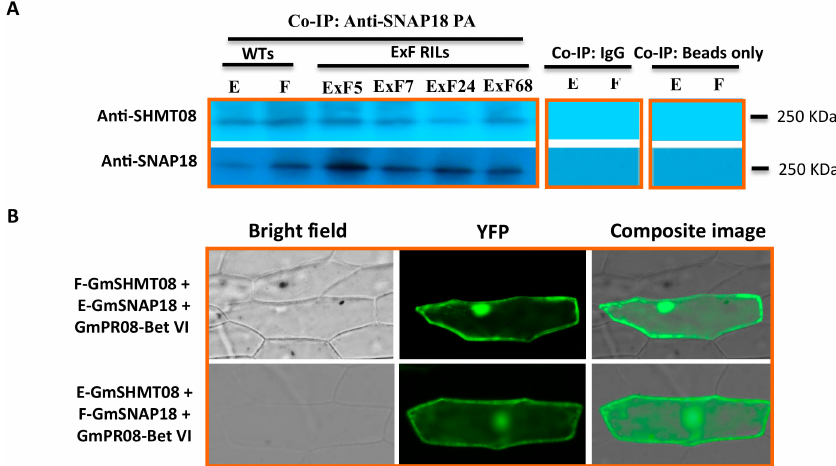
Figure 2. Interaction analyses of GmSNAP18 and GmSHMT08 proteins carrying resistant and susceptible allele combinations by Co-immunoprecipitation (Co-IP) and BiFC assay. ( A ) The total protein extracts of soybean Forrest, Essex, and four ExF RIL (Figure S1) roots were immunoprecipitated with Anti-GmSNAP18 PA. Blots from the eluted fraction were probed with both anti-SHMT08 and Anti-GmSNAP18. Upper bands on the panel (~ 250 KDa) correspond to the multi-protein complex including the tetrameric GmSHMT08 protein, lower bands on the panel (~ 250 KDa) correspond to the multi-protein complex including the GmSNAP18 protein. Native PAGE conditions (non denaturant) and western hybridization of the eluted fraction using both anti-GmSHMT08 and anti-GmSNAP18 antibodies showed the co-localization of the GmSHMT08 and GmSNAP18 binding. IgG and beads were used for Co-IP experiments as a negative control and technical control, respectively ( B ) BiFC analysis between GmSHMT08, GmSNAP18, and GmPR08-Bet VI proteins. The coding sequences of resistant Forrest (F) and susceptible Essex (E) alleles from GmSNAP18 and GmSHMT08 were cloned into pSAT4-nEYFP-C1-B and pSAT4-cEYFP-C1 to generate nEYFP-SNAP18 and cEYFP-GmSHMT08 fusions, respectively. GmPR08-Bet VI was cloned into pG2RNAi2 . Various combinations of cEYFP and nEYFP control fusions were co-expressed in onion epidermal cells by particle bombardment (Figure S2). Co-IP and BiFC assays indicated that resistant and susceptible alleles of GmSNAP18 and GmSHMT08 can associate each